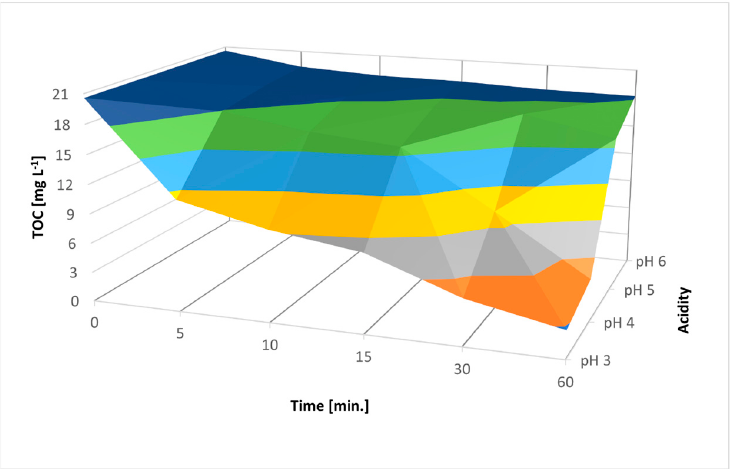
Figure 12. ANOVA results for different pH values with optimal parameters of 400 mg L − 1 H 2 O 2 and UV irradiation with 500 mg ZVI and 50 mg L − 1 AM E123.